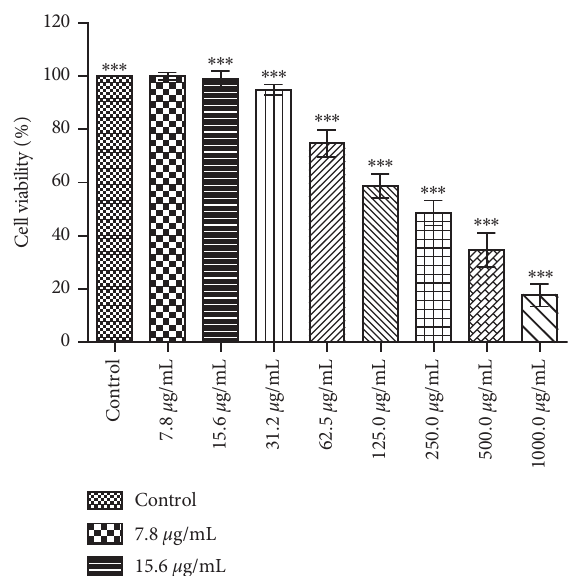
Figure 1: Cytotoxicity effect of crude extract on SH-SY5Y cells exposed to different concentration (7.8–1000 µ g/mL). The per- centage of cells viability is shown versus concentration of the tested crude extract. ∗∗∗ p < 0 . 001 represented significantly different values from control and tested samples. The values represent mean ± SD from three ( n � 3) independent